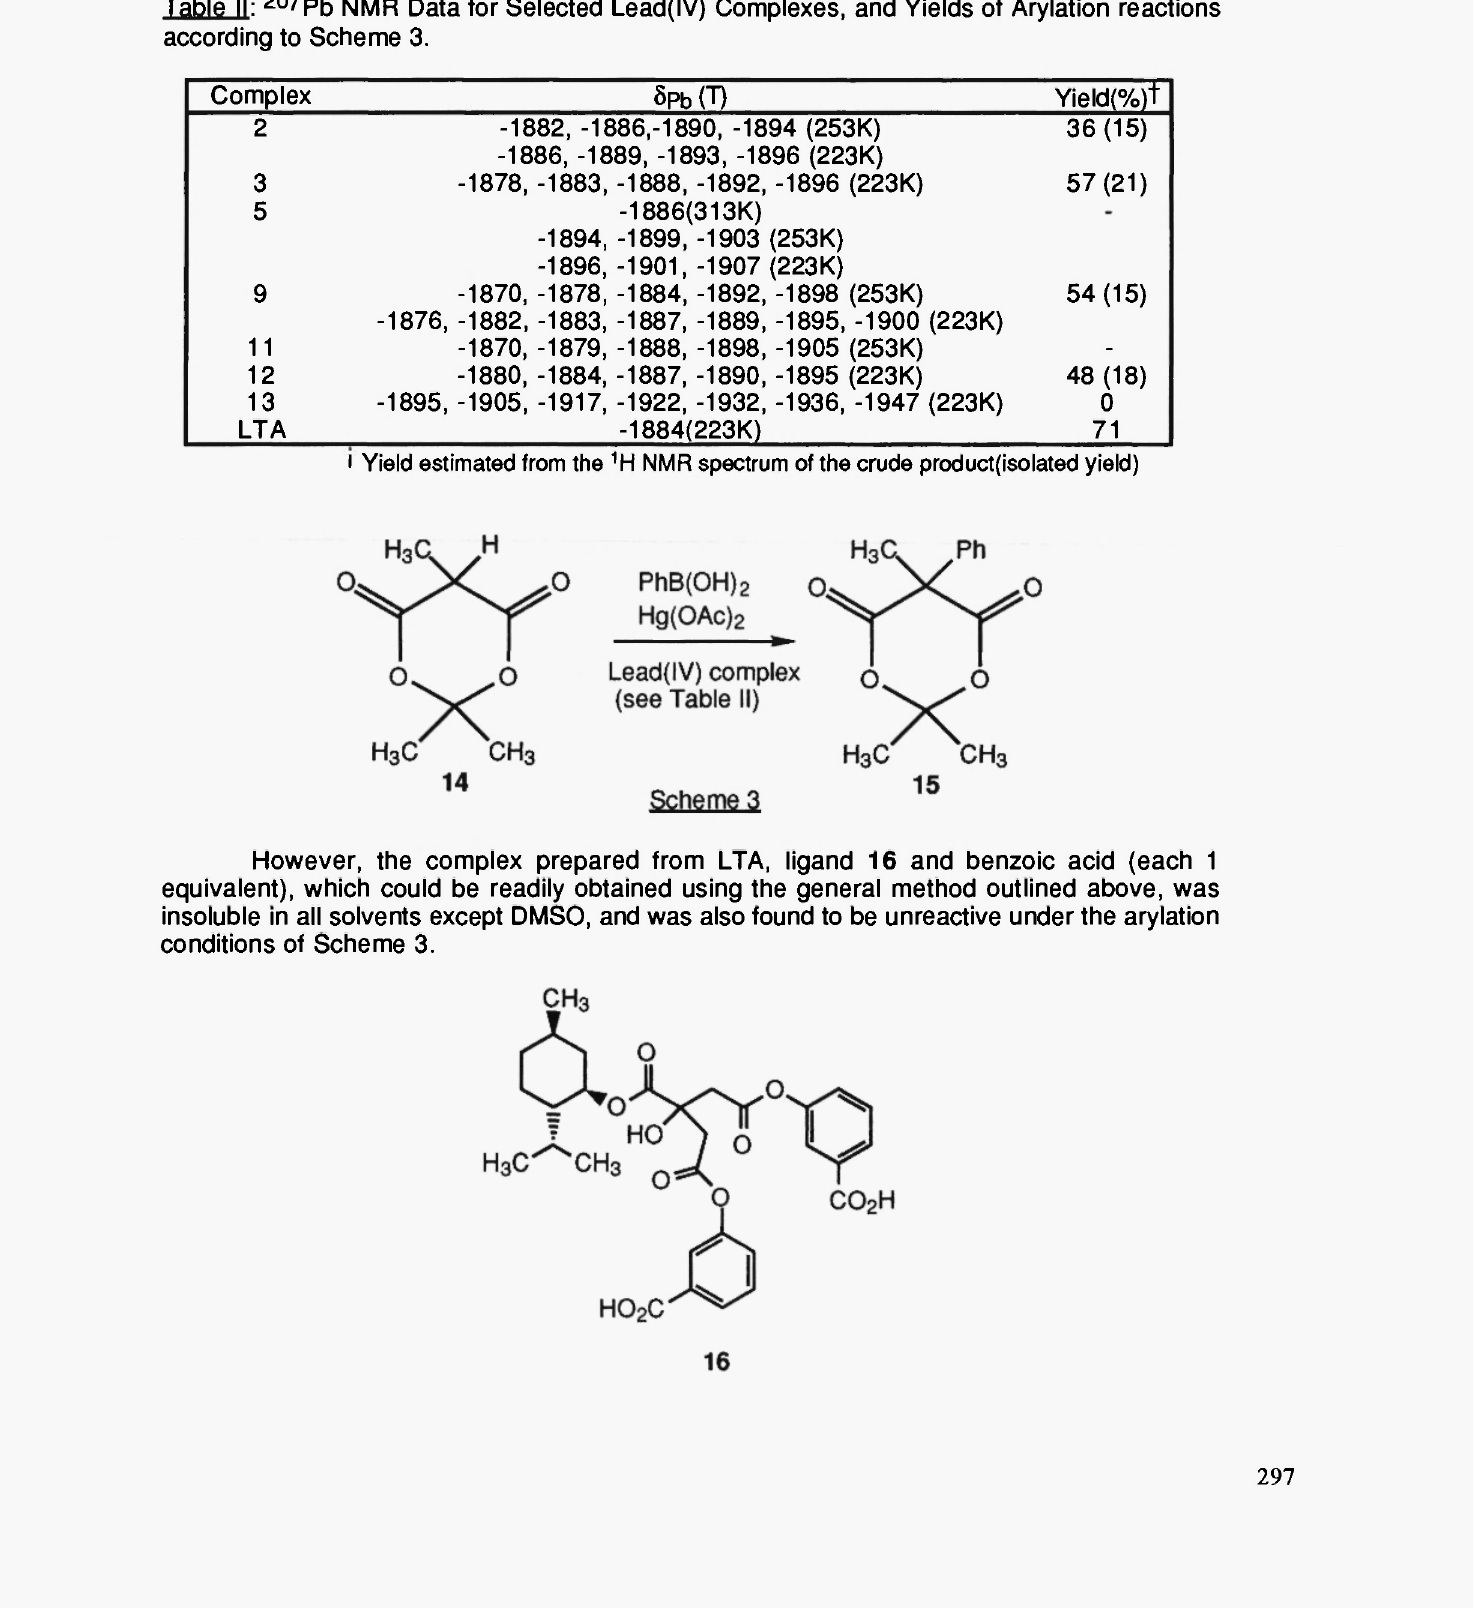
Table II: 207 Pb NMR Data for Selected Lead(IV) Complexes, and Yields of Arylation reactions according to Scheme